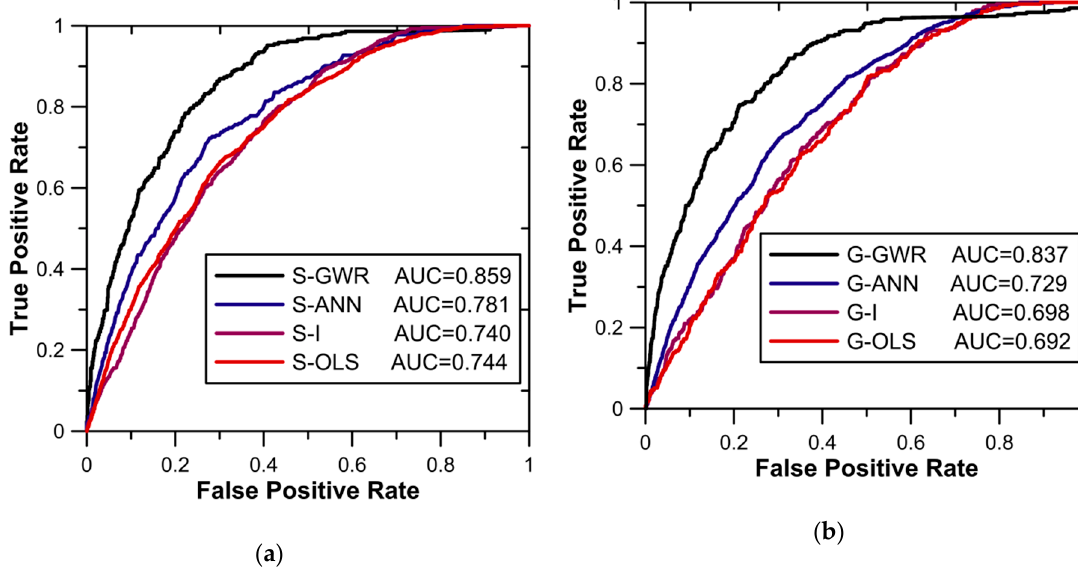
Figure 8. ROC curves and area under the curves (AUC) for the susceptibility maps produced by GWR, ANN, I, OLS. ( a ) Slope unit; ( b ) grid unit.